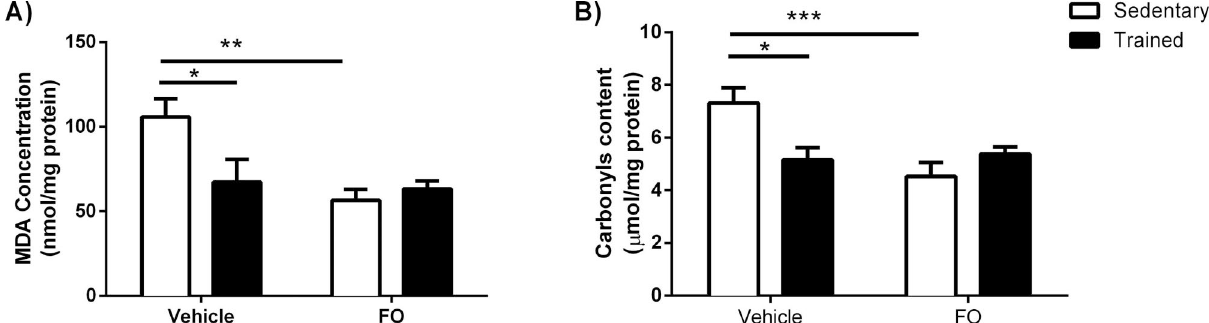
Figure 1 - Oxidative stress biomarkers were evaluated in the hearts of juvenile rats. All data are presented as mean ± SEM. These rats were subdivided into exercised and sedentary groups, and they received one single daily dose of fish oil or vehicle solution (for 4 weeks). A) Lipid peroxidation evaluated by malondialdehyde concentration; B) Protein oxidation evaluated by the concentration of carbonyls. *p < 0.05; **p < 0.01; ***p < 0.001 in a Two-way ANOVA test followed by the